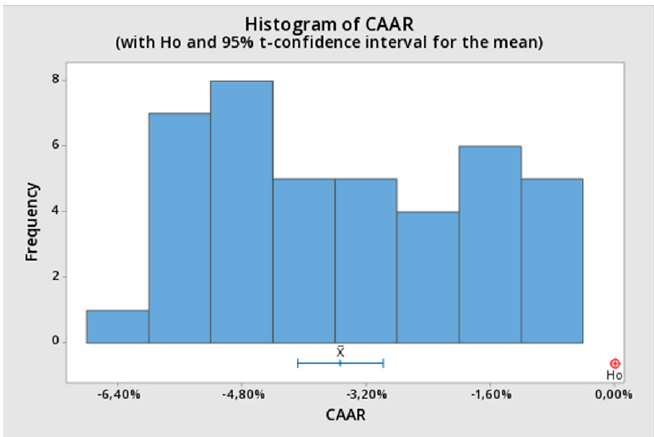
Figure 3. t -Test P-P plot of CAAR for E ( − 40,+40) .